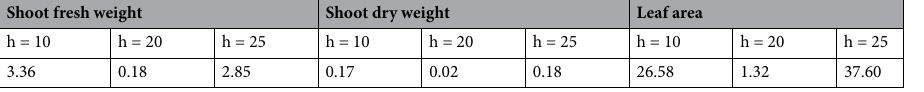
Shoot fresh weight Shoot dry